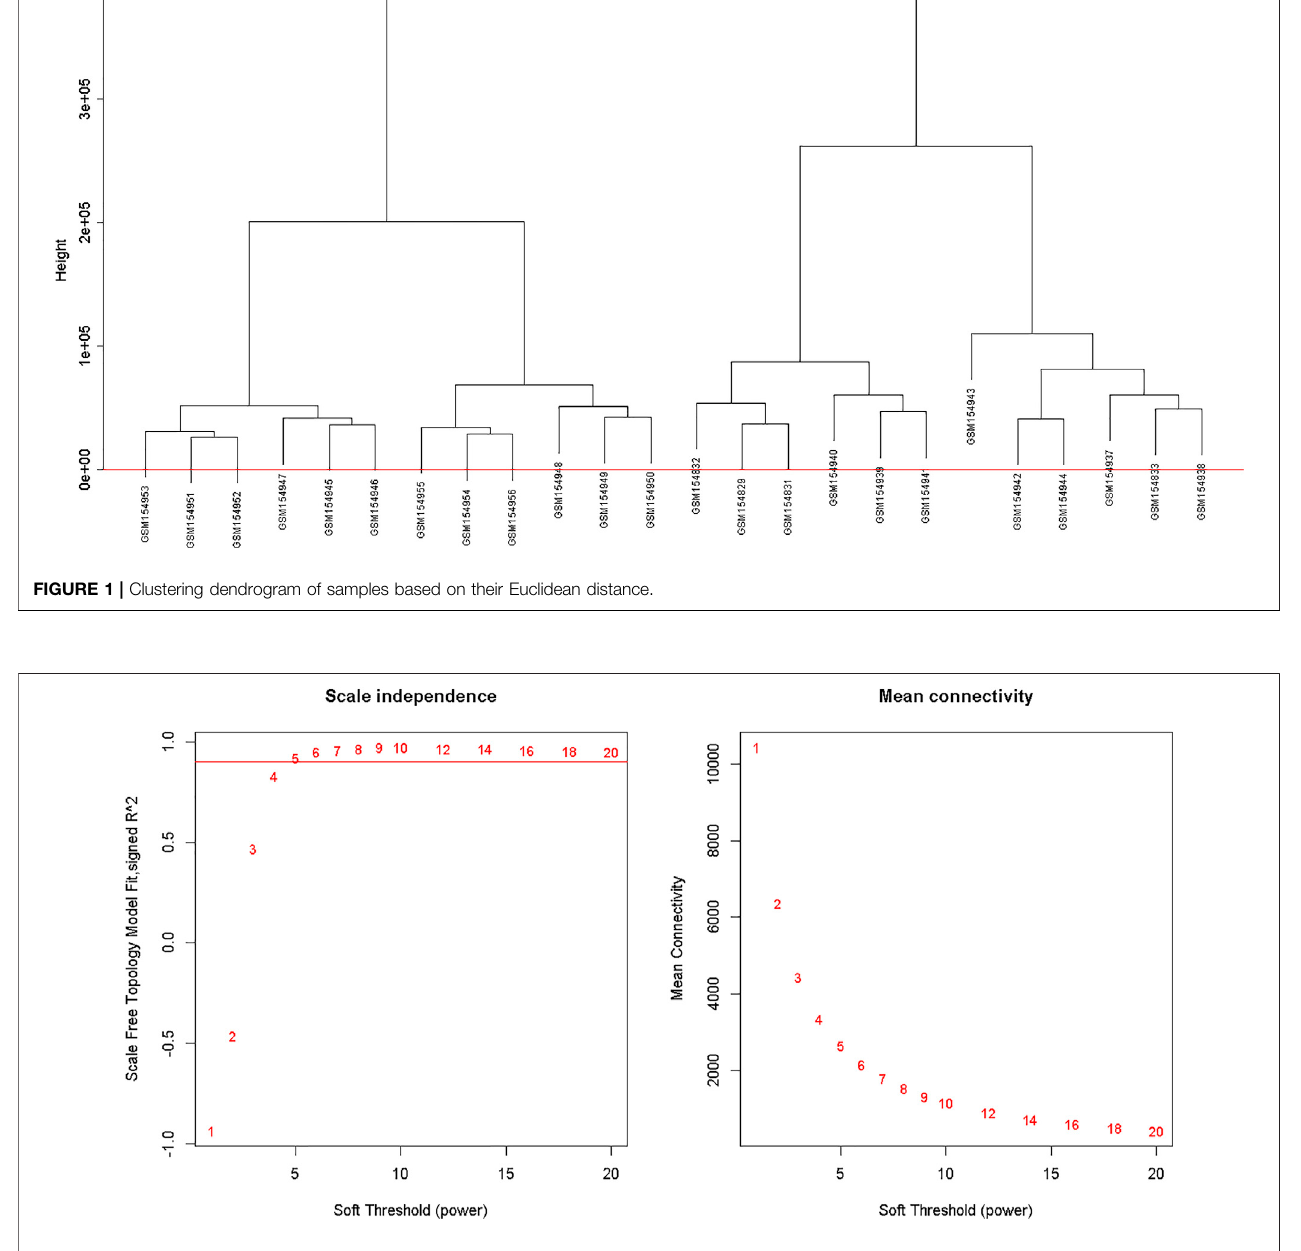
Frontiers in Genetics |